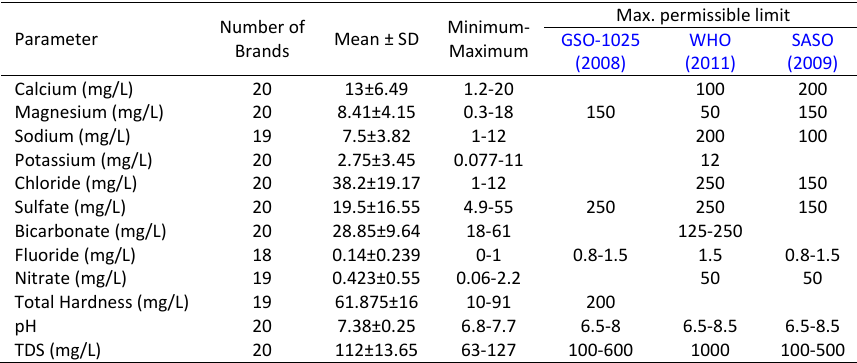
Table 2: Comparison of UAE bottled water quality with standards